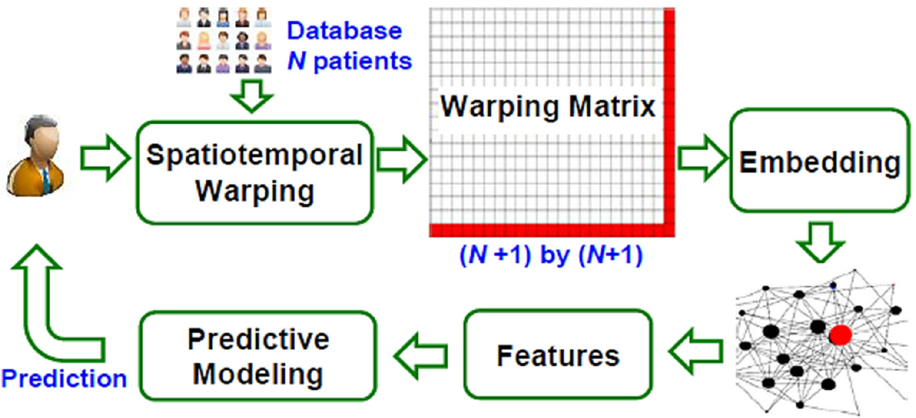
Figure 21. Flow chart of the network-based data analytics in MESH [69] (Reprinted with permission from ref. [69]. Copyright 2021 IEEE).